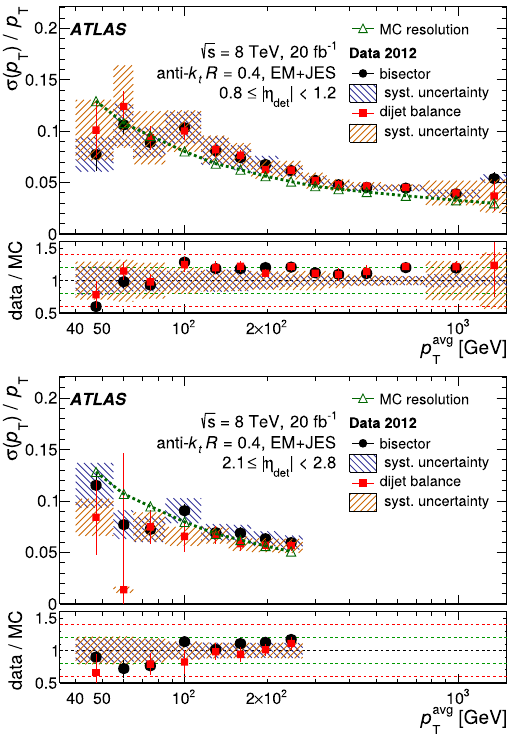
Fig. 20 Relative jet energy resolution obtained for EM+JES cali- brated jets using the bisector (filled circles) and dijet balance (filled squares) methods, respectively. The MC simulated resolution derived from matching truth-particle jets with calorimeter jets is presented by the open triangles connected by dashed lines. The error bars reflect the